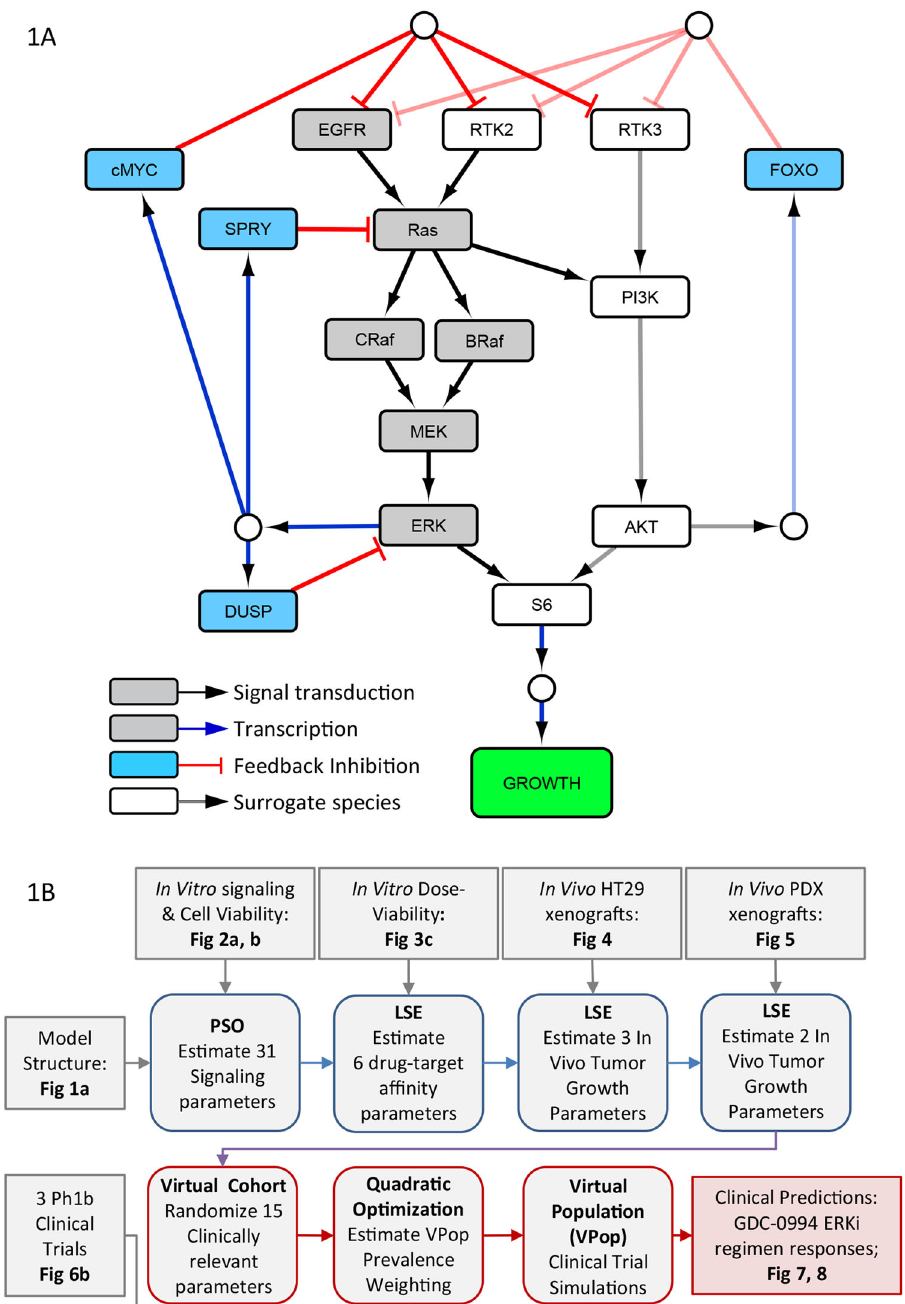
receptors (RTK2, 3), and signal integration (S6) components. b Model development work fl ow, highlighting data inputs ( gray boxes ), pre-clinical modeling tasks ( blue boxes ), and clinical translation modeling tasks ( red boxes ), and associated fi gures. PSO particle swarm optimization,